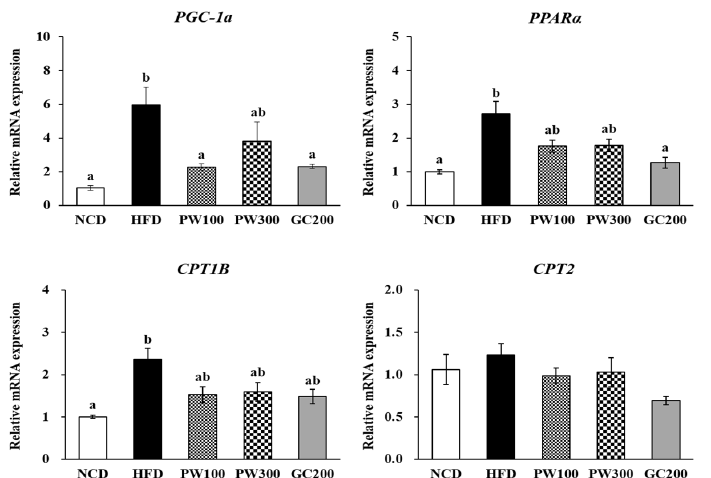
Figure 5. Effects of Polygonum multiflorum Thunb. hot water extract on FA oxidation-related gene expression in interscapular BAT in HFD-induced obese mice. Data are expressed as means ± SE. Values with different superscript letters are significantly different at p < 0.05 as determined by one-way ANOVA followed by Tukey’s HSD test.